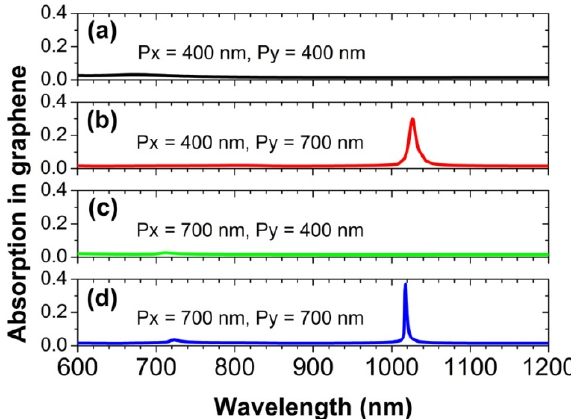
Figure 5. The calculated absorption spectra of the graphene monolayer for different array periods at at normal incidence. normal